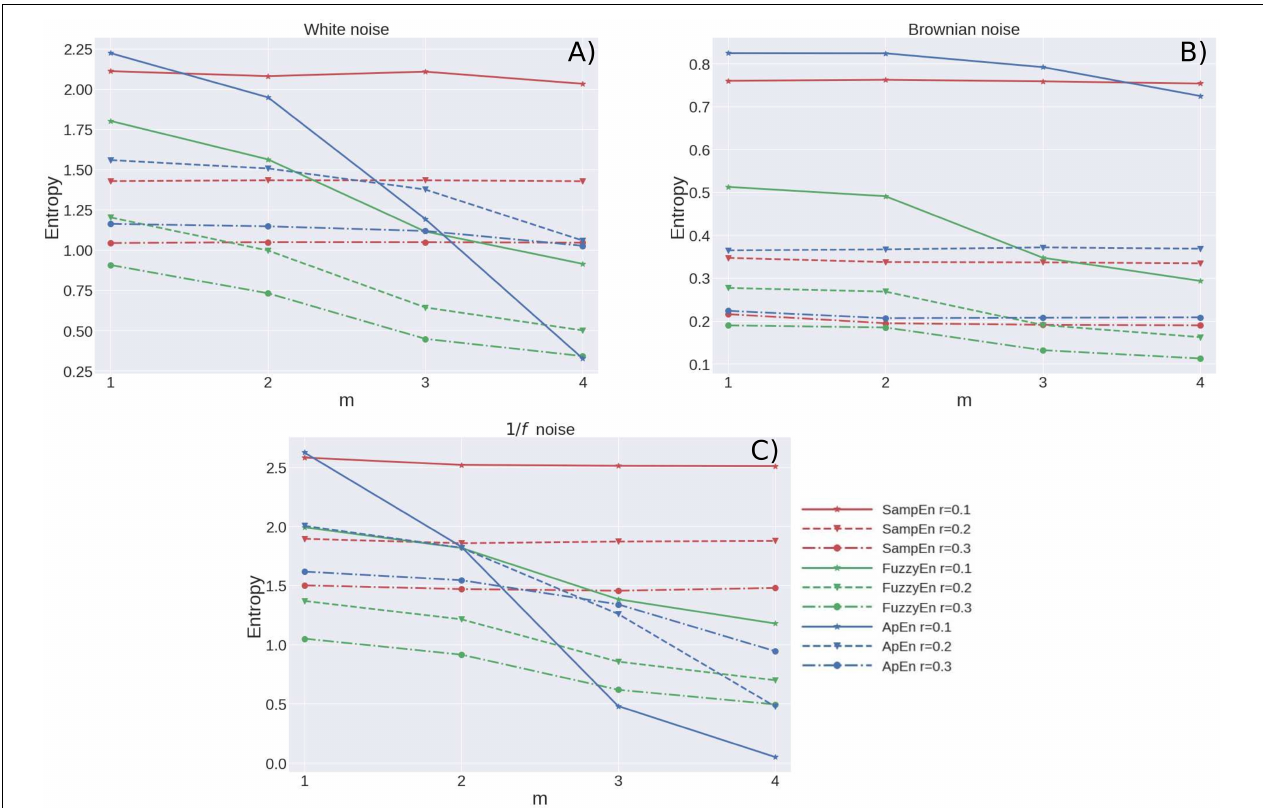
FIGURE 1 | Values of SampEn ( A ; red), ApEn ( B ; blue), and FuzzyEn ( C ; Green) for self-affine time series with 3000 data and different values of m (1, 2, 3, and 4) and r (0.1, 0.2, and 0.3). SampEn behaves stably for different values of m , the variations in entropy values with respect to r are normal, the largest entropy values correspond to the smallest values of r and vice versa, the smallest entropy values correspond to the larger values of r